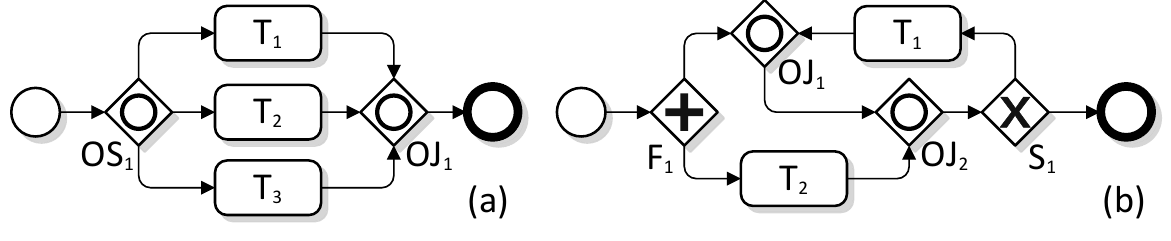
Figure 1. Two processes in BPMN notation containing OR-joins